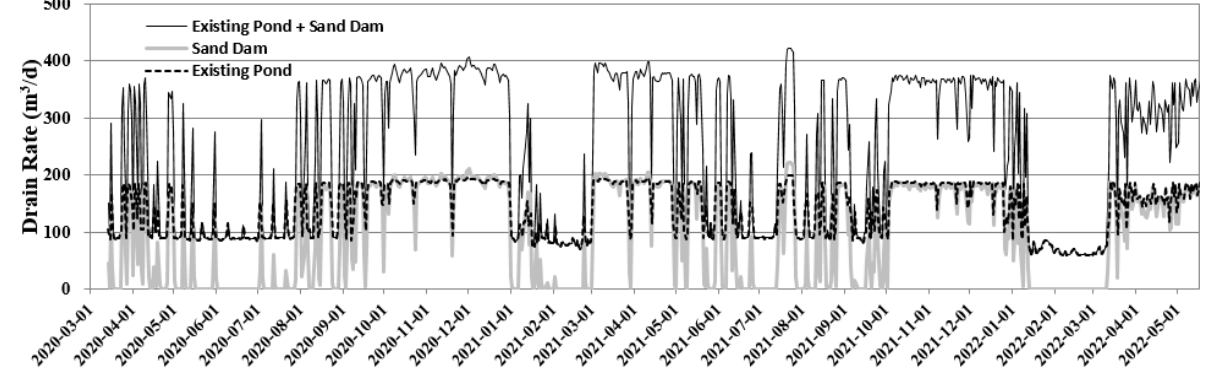
Figure 12. Water drain rates for 50% reduction in inflow.